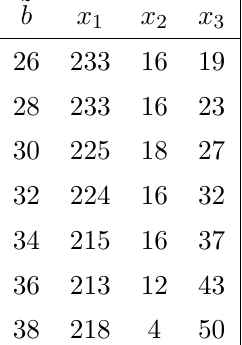
Table 5 . Anomaly-free, non-exchangeable T = 0 U(1) models with j q j (cid:20) 3 that cannot be unHig- gsed to an anomaly-free SU(2) model because of the gravitational